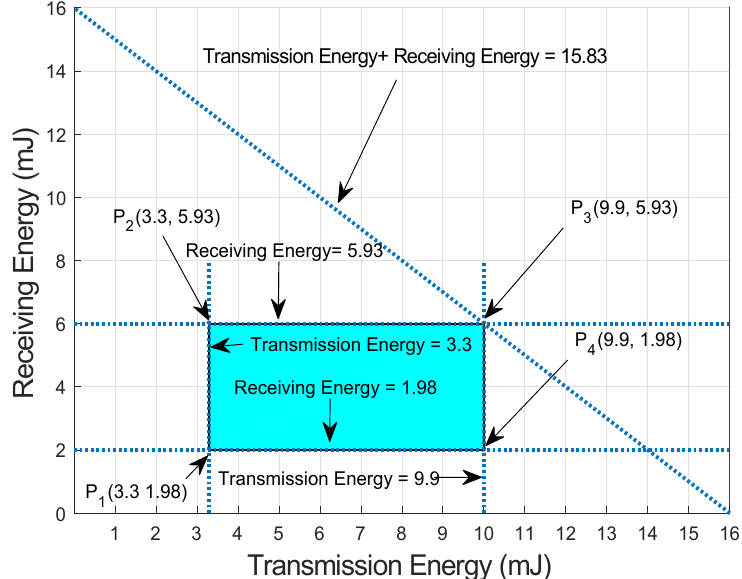
Figure 14. EC Feasible Region for Both Proposed